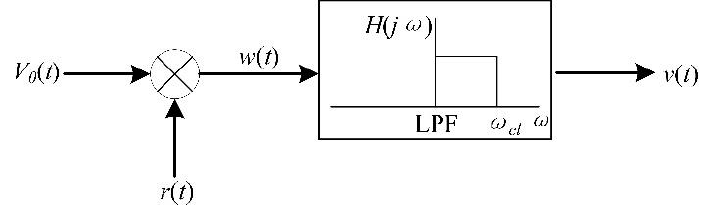
Figure 4. Block diagram of a synchronous demodulator.